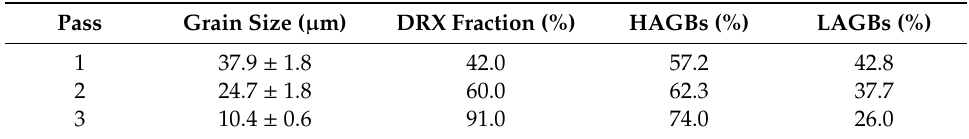
Table 1. The changes of main indexes during the CEE-AEC process, including grain size, DRX fraction, high angle grain boundaries (HAGBs), and low angle grain boundaries (LAGBs). Pass Grain Size ( µ m) DRX Fraction (%) HAGBs